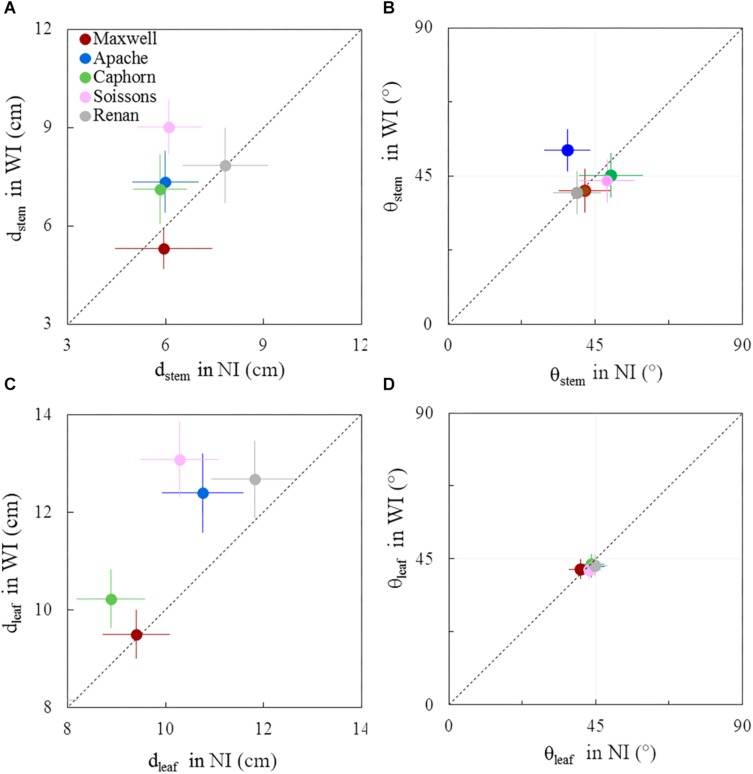
Horizontal spacing and azimuth orientation of stems and leaves in WI treatments vs. NI treatments, at 1272°Cd. The stem spread (dstem; A), leaf spread (dleaf; C), stem azimuth angle (θstem; B), and leaf azimuth angle (θleaf; D). Symbols represent the mean values taking into account only well-developed axes, with hcol(1) > 10 cm, for 30–60 plants per treatment. Error bars represent 95% confidence intervals of the mean estimates. The dotted line represents the line 1:1.